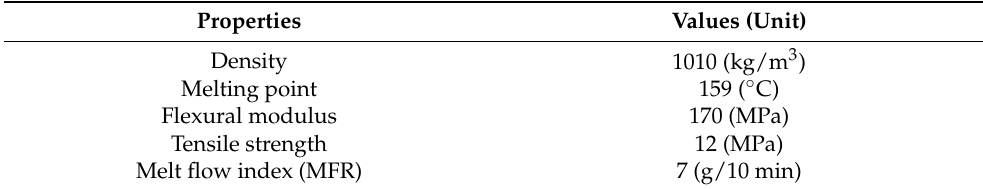
Table 1. Intensive and mechanical properties of Pebax5533 SA01 MED + 20 wt% BaSO 4